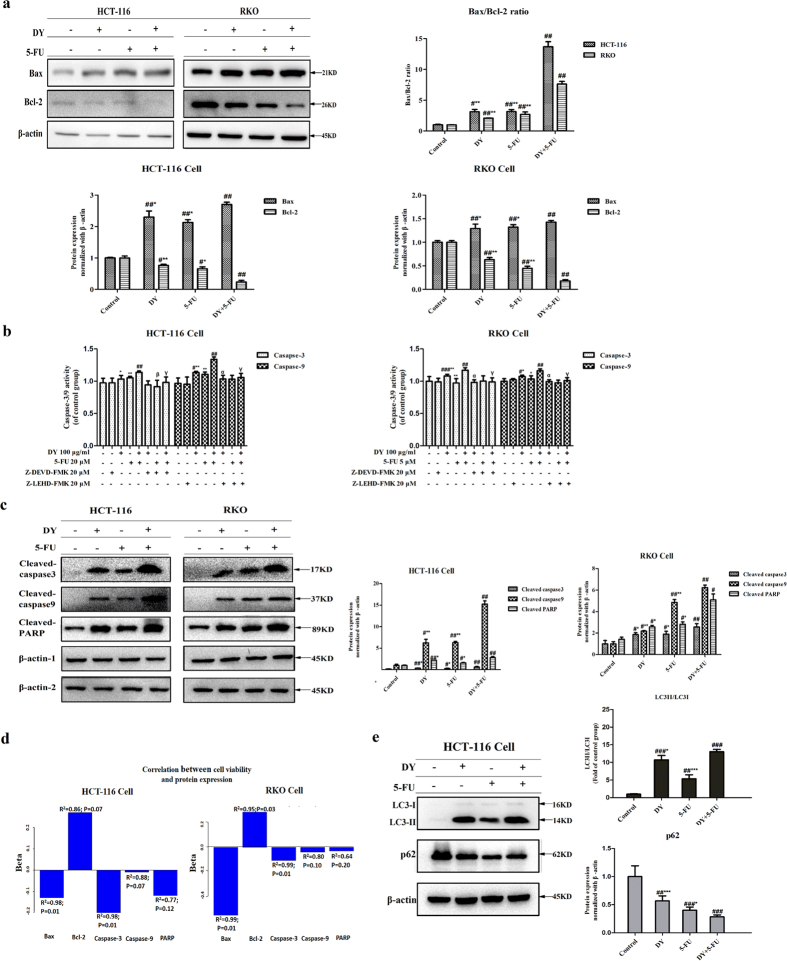
DY promoted 5-FU-induced apoptosis via a caspase-dependent apoptosis pathway.(a) Effects of 48 treatment with DY and/or 5-FU on the expression levels of Bax and Bcl-2 proteins in two CRC cell lines. (b) Activities of caspase-3/9 in two CRC cell lines treated with DY and/or 5-FU for 48 h with or without the caspase-3 & 9 inhibitors (Z-DEVD-FMK & Z-LEHD-FMK). (c) Expression levels of cleaved-caspase 3/9 and cleaved PARP in two CRC cell lines following the treatment with DY and/or 5-FU for 48 h were measured and normalized by β-actin (β-actin-1, cleaved caspase-3/9; β-actin-2, cleaved PARP). (d) Correlation between cell viability and protein expression was evaluated by a log-norm distribution analysis. (e) Cells were treated with either DY or 5-FU or their combination for 24 h, the expression levels of LC3I/II and p62 were then analyzed and respectively normalized by β-actin. The ratios of LC3II/LC3I and expression levels of p62 are presented in right histograms. All the values are expressed as mean ± SD (n = 3). #P < 0.05, ##P < 0.01, ###P < 0.001, vs control group. While *P < 0.05, **P < 0.01, ***P < 0.001, vs (5-FU + DY) group, α, β and γ respectively indicated a significant difference was found between DY, 5-FU or DY + 5-FU group and their casapse-3/9 inhibition groups (P < 0.05).